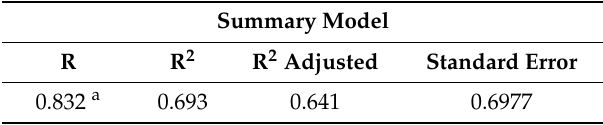
Table 9. Determination coefficients: Wheel-tracking test and topographic settlement.